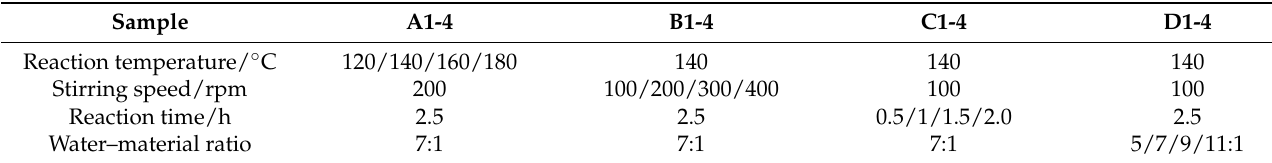
Figure 4. Experimental procedure of CSH whiskers preparation. Table 2. Synthesis parameters for samples.